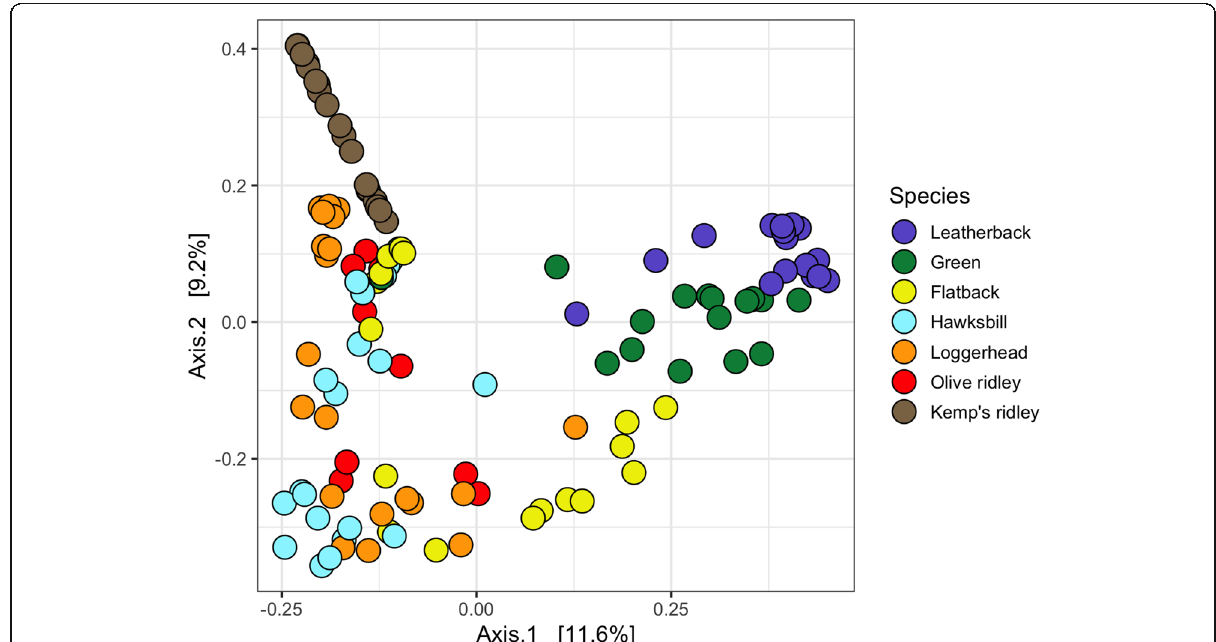
Fig. 3 Principle co-ordinate analysis (PCoA) of Bray-Curtis distance showing functional microbial diversity across all species. Significant differences for microbiota composition existed between all species (R 2 = 0.29, p = 0.001). For pairwise comparisons between species see Table